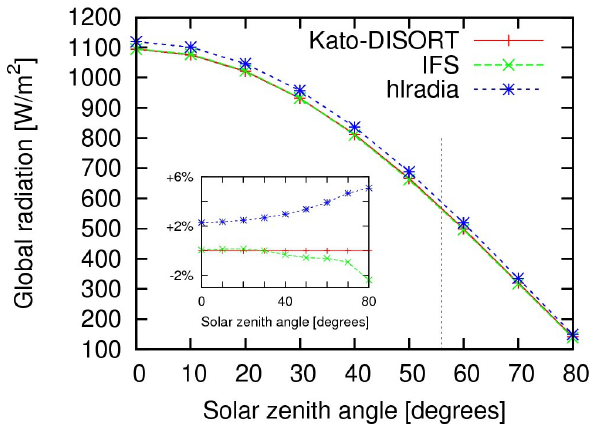
Figure 5. As for Fig. 1 but for surface albedo (experiment 3). The vertical dashed line at 0.18 marks the reference albedo used in ex- periment 1–3, 5–6, 9 and 11. The vertical dashed line at 0.7 marks the albedo used in experiment 10 and 12.